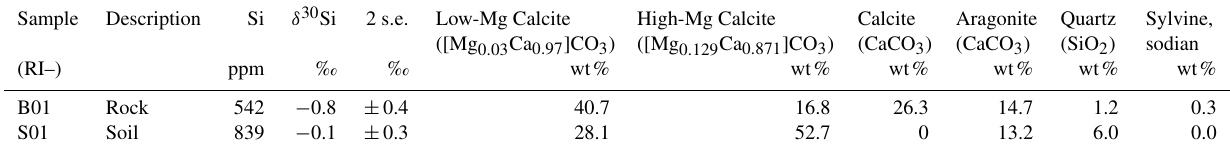
Table 2. Silicon concentrations, Si isotope ratios and XRD data ∗ for bulk rock samples from Rottnest Island. Sample